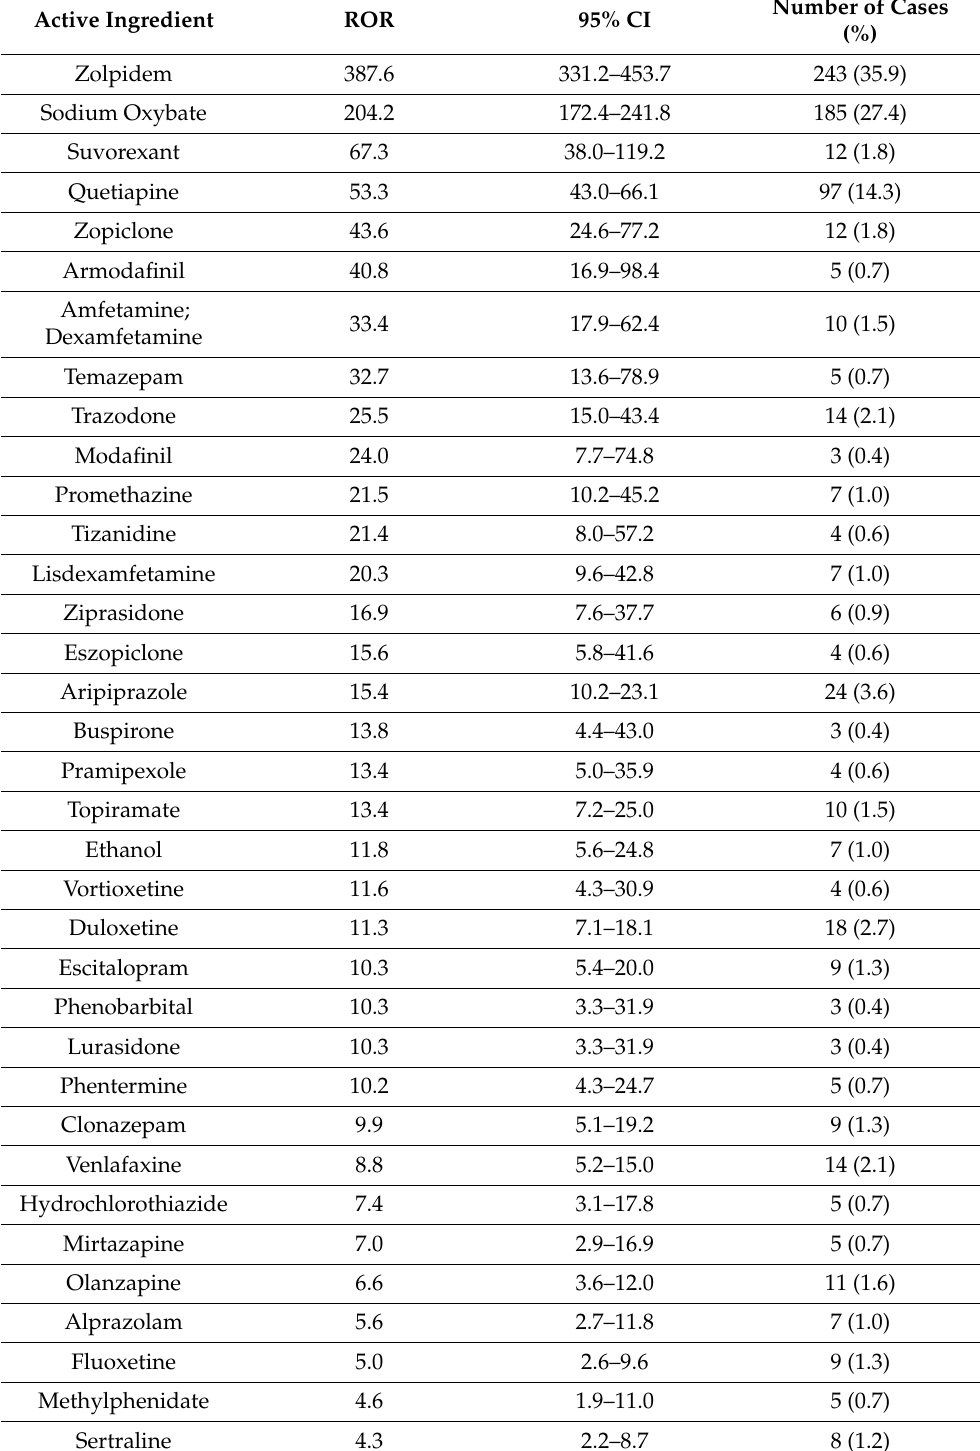
Table 3. Disproportionality analysis for reports of sleep-related eating disorder